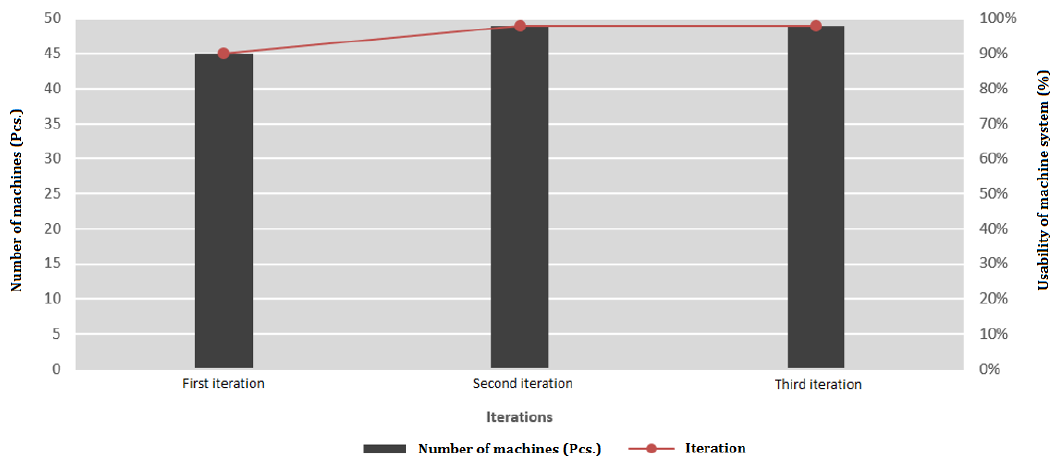
Figure 7. The comparison chart of equipment lines usability during